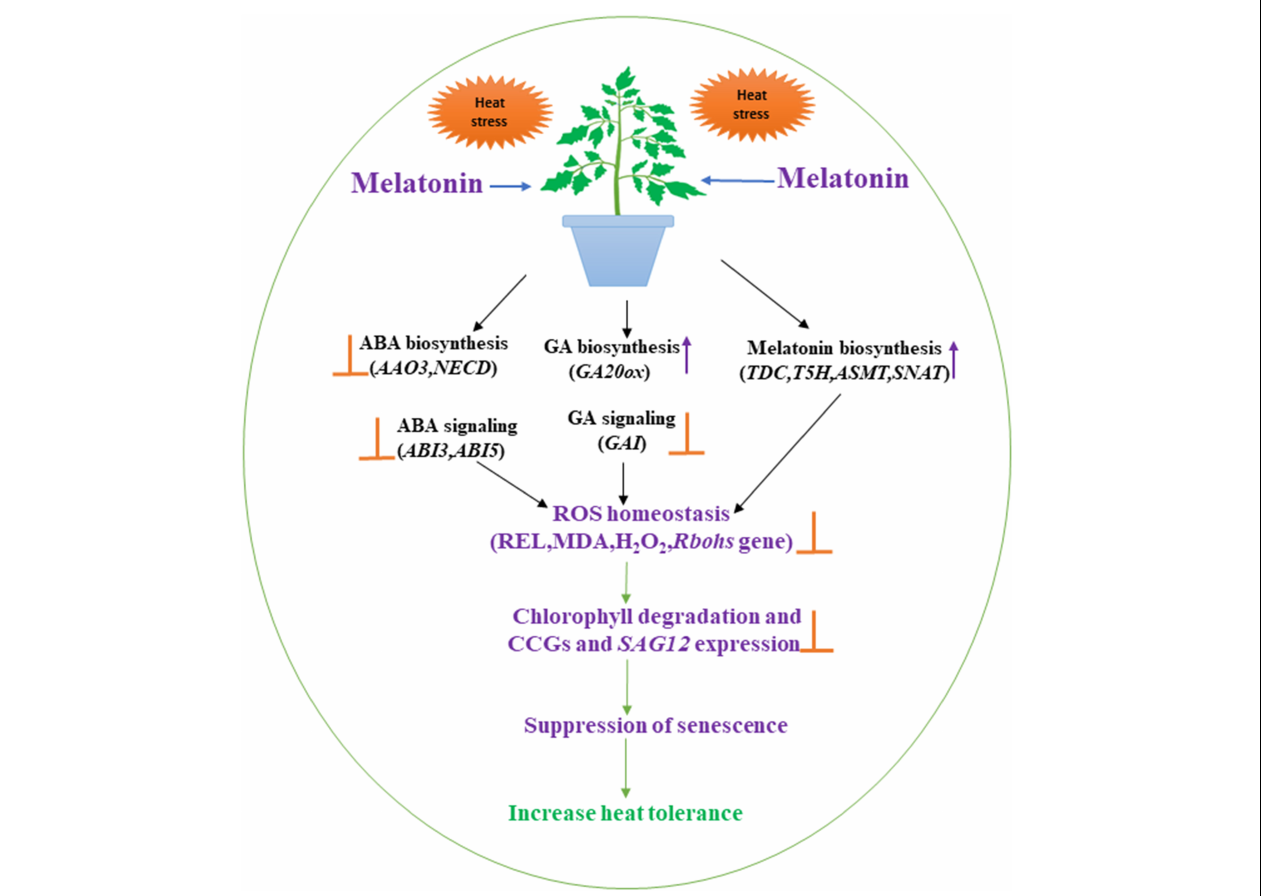
FIGURE 8 | A probable mechanism of melatonin-mediated heat-induced leaf senescence resulting in coordination with ABA and GA biosynthesis and signaling pathway. The arrow denotes increases and bar denotes